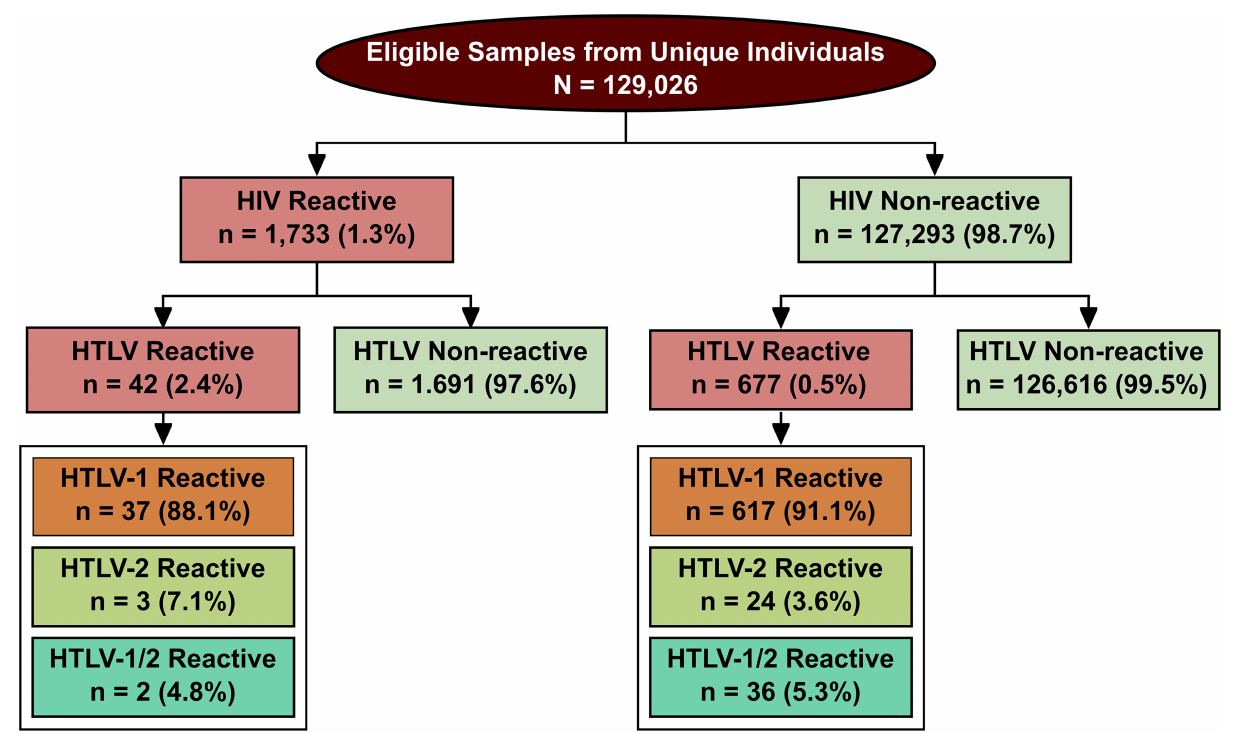
FIGURE 2 | Flowchart describing study design and results of HIV and HTLV infection status in the studied population. All samples determined positive by ELISA screening were then confirmed by WB.